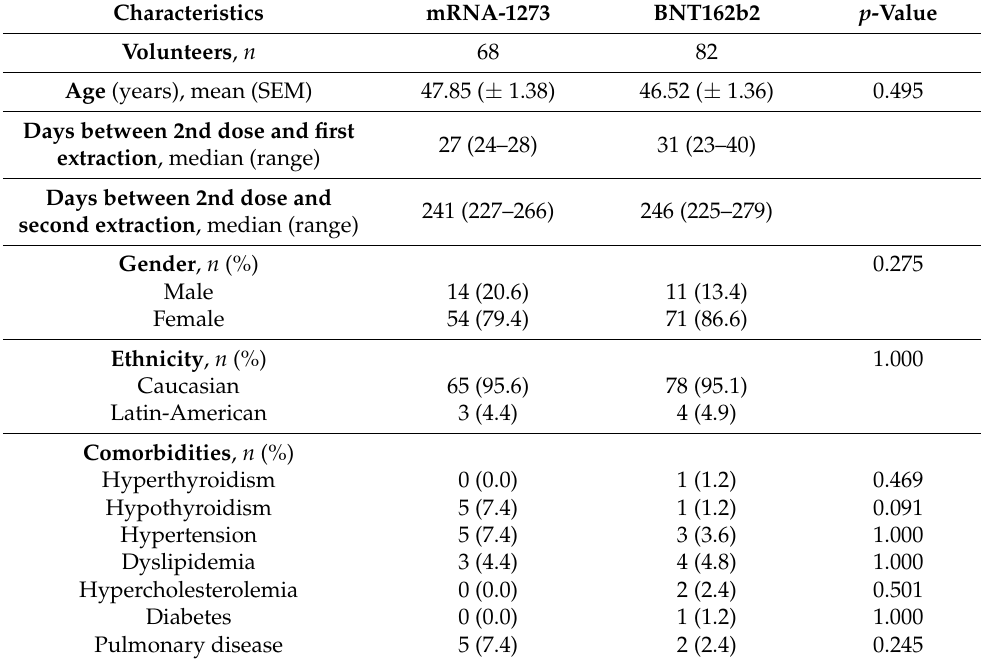
Table 1. Characteristics of the vaccinated